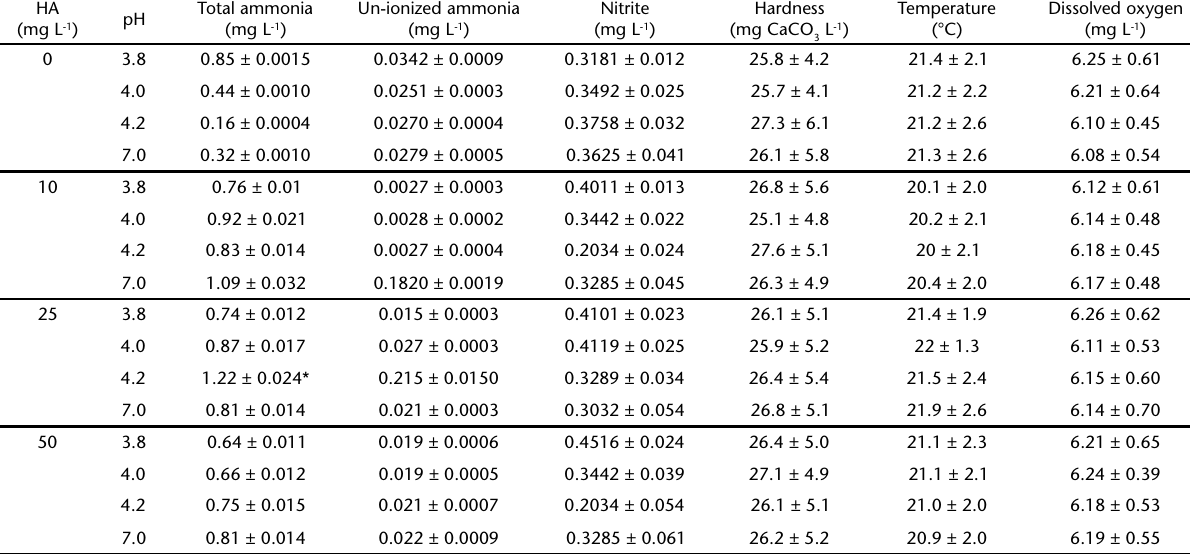
Table 2. Water quality parameters at different pH and humic acid (HA) levels for Rhamdia quelen . HA (mg L -1 )